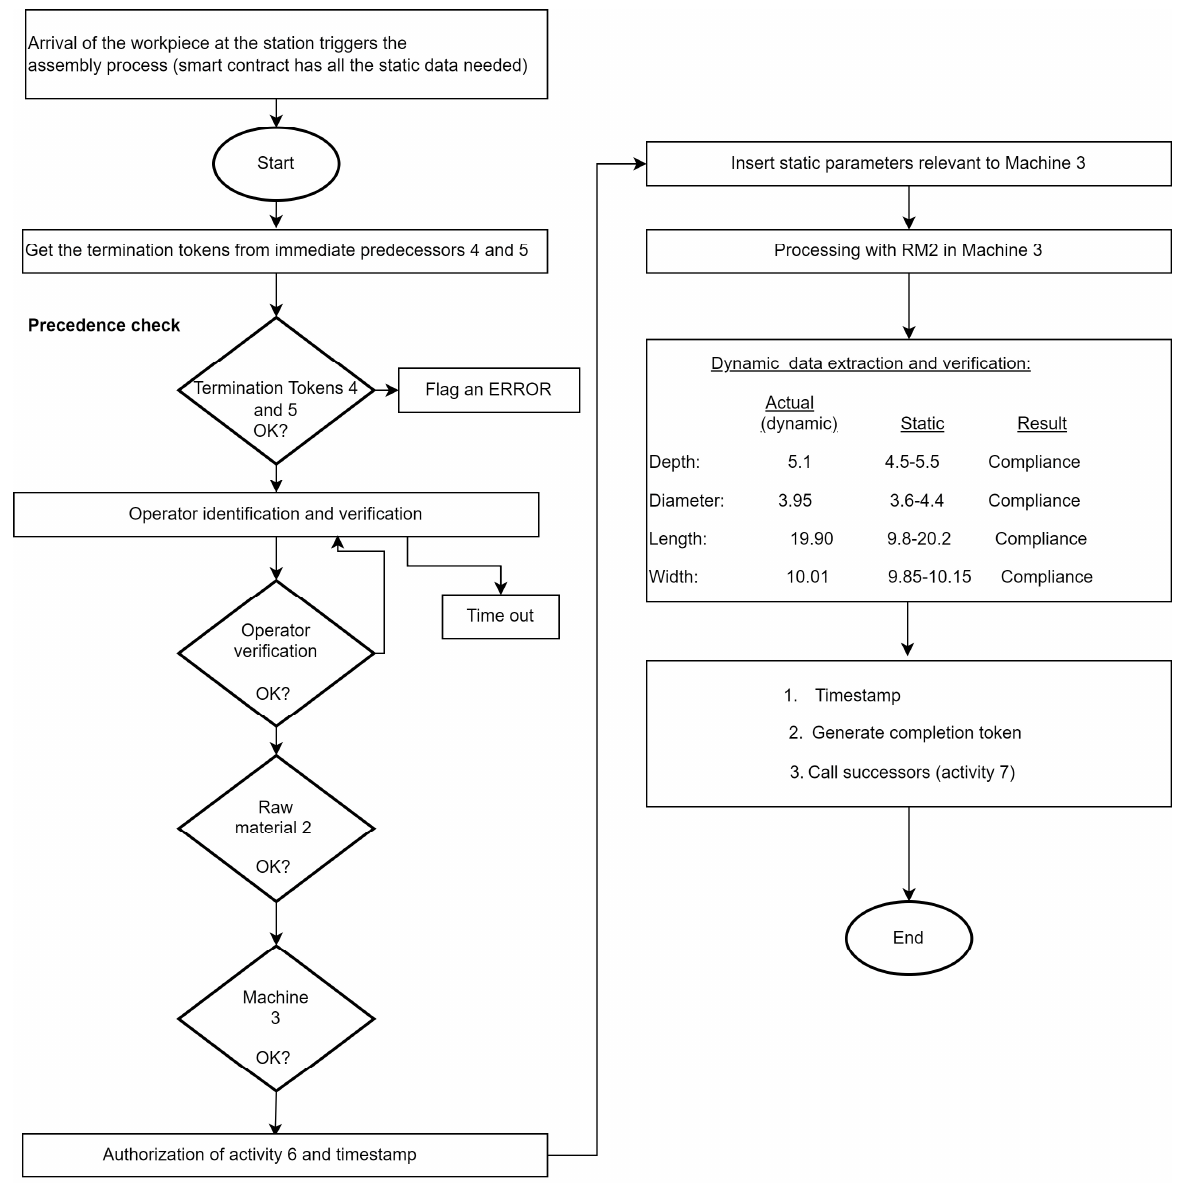
Figure 4. Verification logic of the smart contract related to activity 6 (see Figure 2).